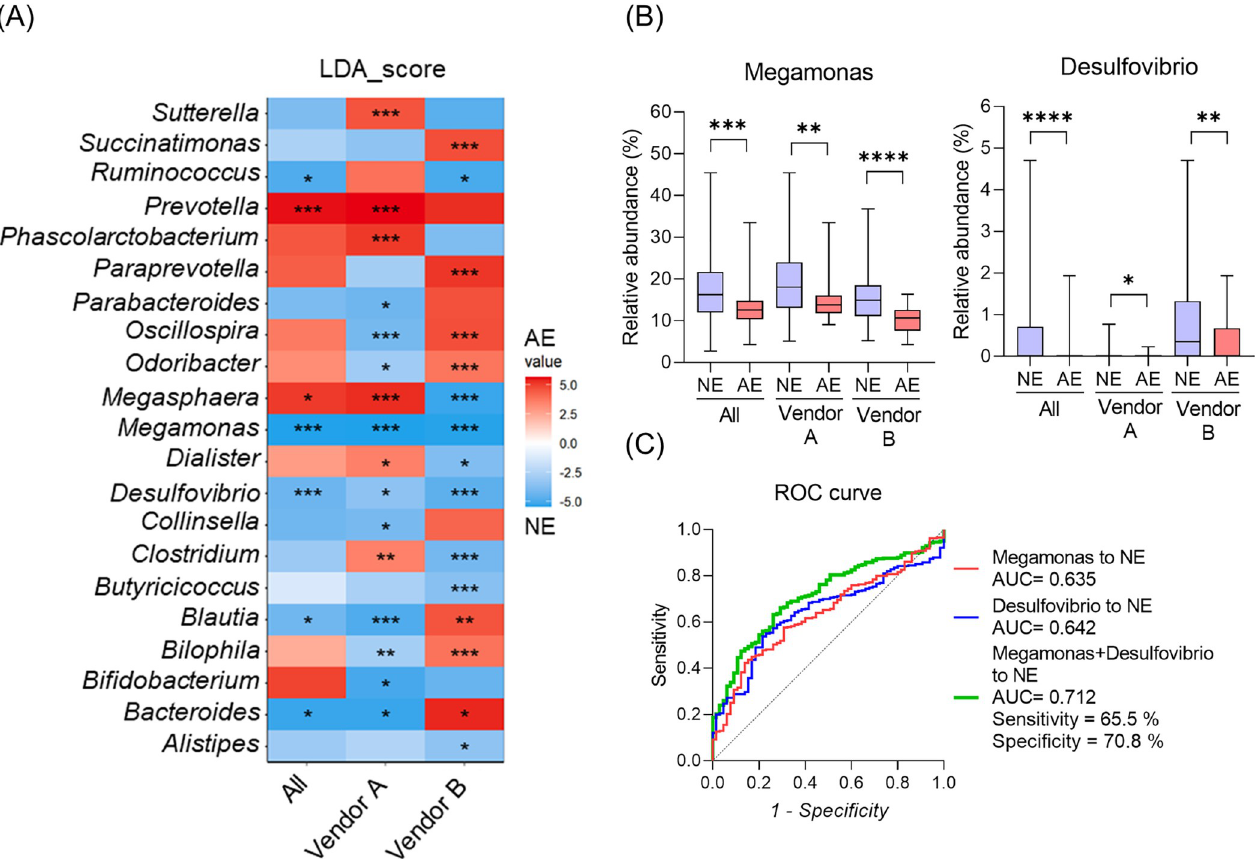
Fig 4. Comparison of fecal microbiome between normal and anovulatory estrous groups. (A) Results of the LEfSe comparison between normal estrous group (NE) and anovulatory estrous group (AE) divided by vendors or individual marmosets. Color bar scale shows LDA sore; red means AE abundance, and blue means NE abundance; p-value: ��� , < 0.001 �� , < 0.01, � , < 0.05. (B) Box plots showing a comparison of the relative abundance of Megamonas and Desulfovibrio between NE and AE. The box extends from the 25th to 75th percentiles, and the line in the middle of the box shows the median. The ends of the whiskers represent the smallest and largest values. Kruskal-Wallis test, p-value: ���� , < 0.0001, ��� , < 0.001, �� , < 0.01, � , < 0.05. (C) ROC curve analysis using Megamonas , Desulfovibrio , and a combination of Megamonas and Desulfovibrio .